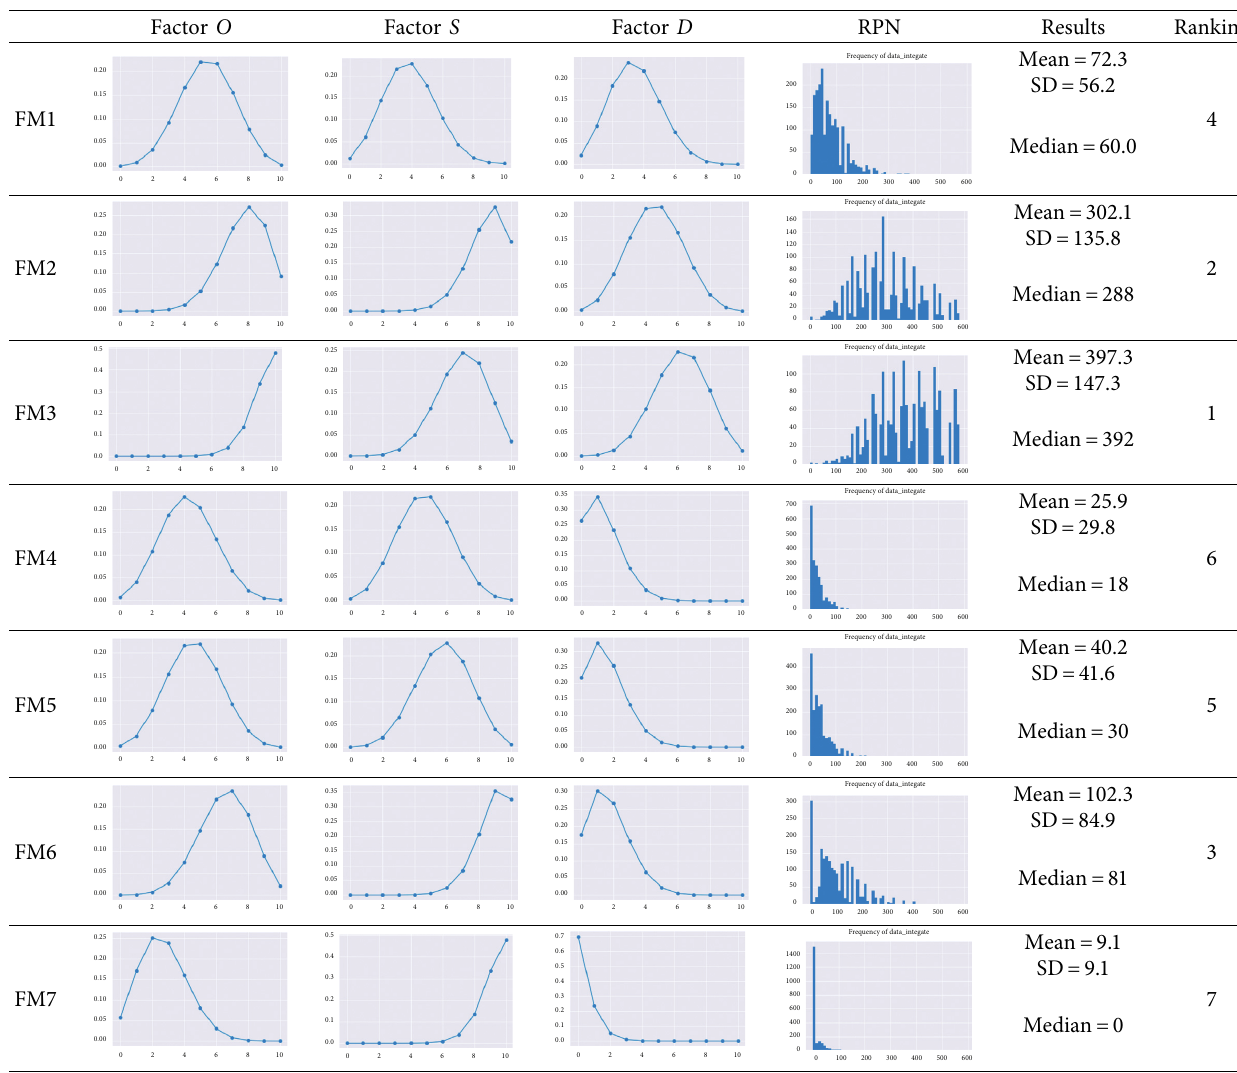
Table 7: The RPN under α �